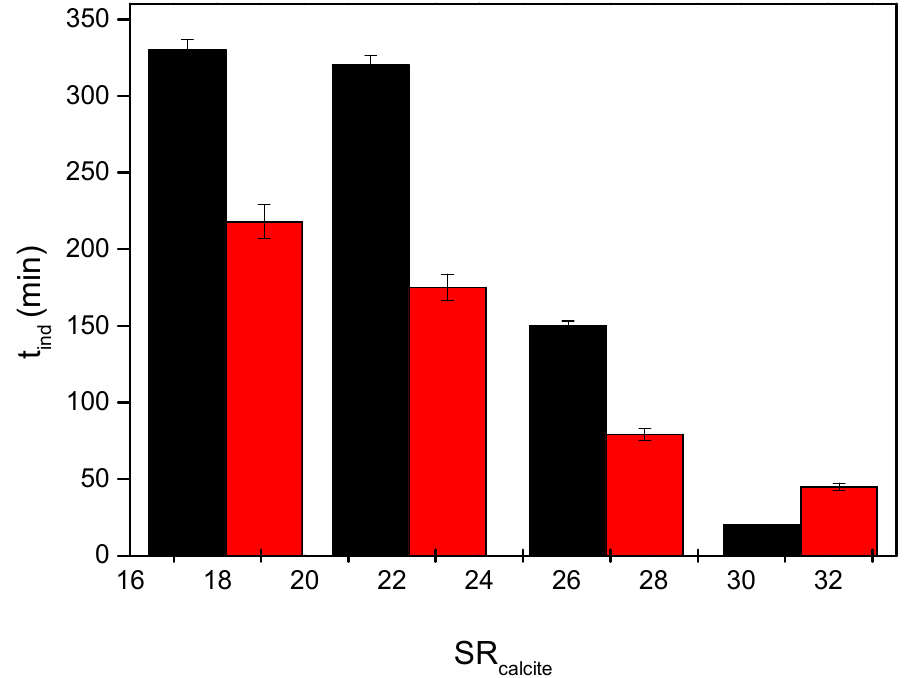
Figure 8. Induction times preceding the precipitation of calcium carbonate as a function of supersaturation ratio with respect to calcite in the presence of nickel under illumination conditions in the presence of 20 mL of active microalgae culture (including nutrient medium); 25 °C, pH 8.50, 0.15 M of NaCl; black bars in the absence of Ni; red bars in the presence of 6.0 μ M of Ni. It should be noted that the differences are clear at lower supersaturations, while at the very high values where induction times were short, the differences are not significant.